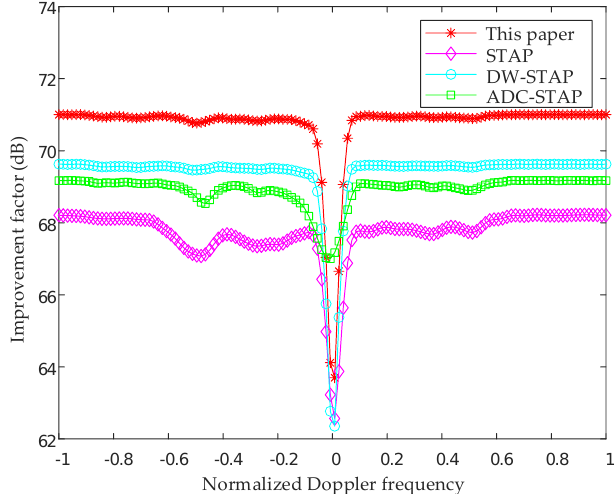
Figure 6. Comparison chart of improvement factors for the 80th distance unit.